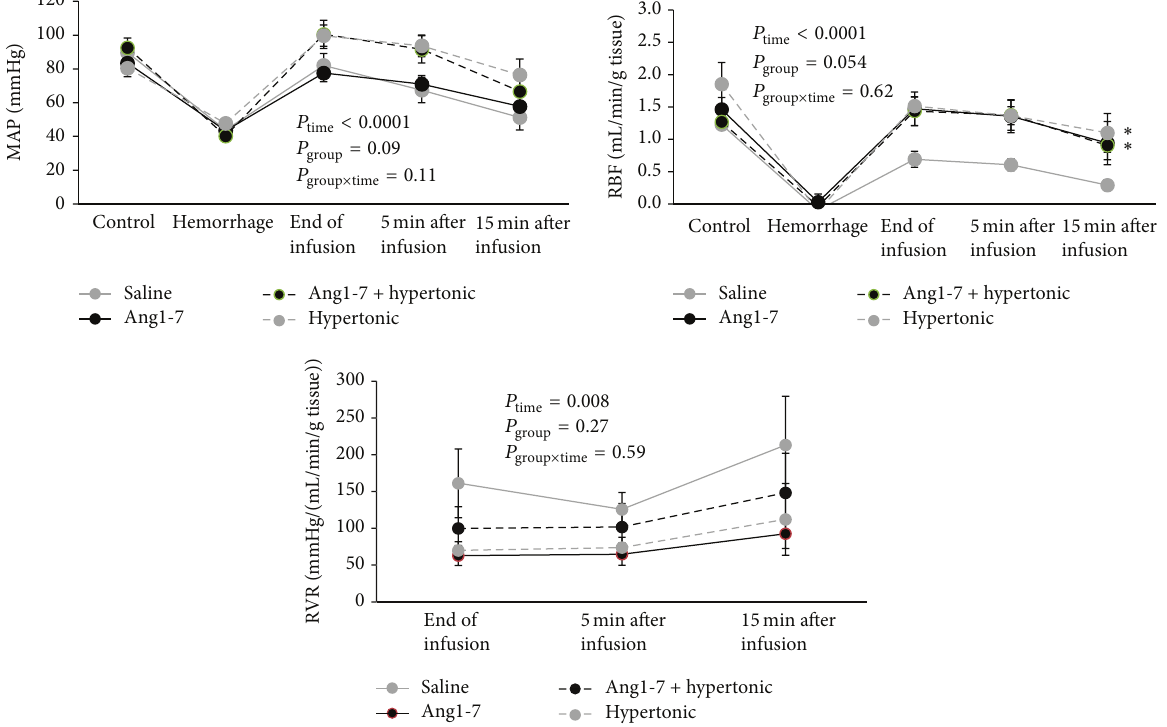
Figure1:MAP,RBF,andRVRresponsestosaline,Ang1-7,Ang1-7+hypertonicsaline,andhypertonicsalinealoneadministrationafter45 min hemorrhagic shock. Data are shown as mean ± SEM. MAP, mean arterial pressure; RBF, renal blood flow; RVR, renal vascular resistance. ∗ means significant difference between vehicle and the other groups. 𝑃 values were derived from repeated measures for